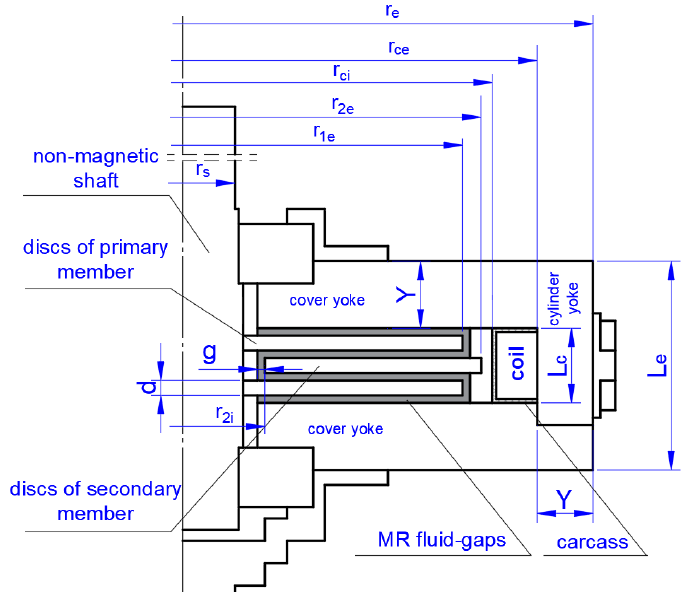
Figure 2. Axisymmetrical cross-section of a two-disc MR clutch (N = 2): L e —external length of magnetic circuit, r e —external radius of magnetic circuit, r s —radius of non-magnetic shaft, r 1 e — external radius of primary member discs, r 2 e —external radius of secondary member discs, r 2 i — inner radius of secondary member discs, d —thickness of primary and secondary member discs, g —thickness of MR fluid gap, L c —external length of coil, r ce —external radius of coil, r ci —inner radius of coil, Y —thickness of cover and cylinder yoke.